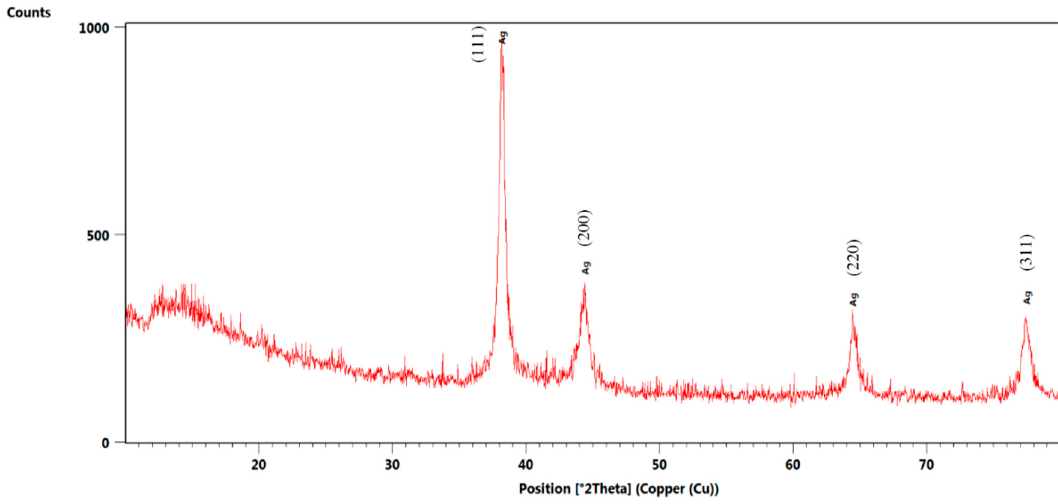
Figure 2. X-ray di ff ractogram recorded for NanoAg. Figure 2. X-ray diffractogram recorded for NanoAg. Figure 2. X-ray diffractogram recorded for NanoAg.